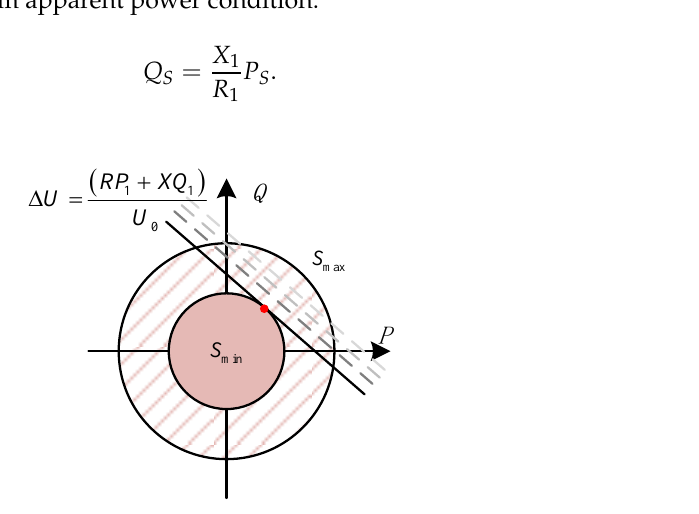
Figure 6. Principle of minimum apparent power.